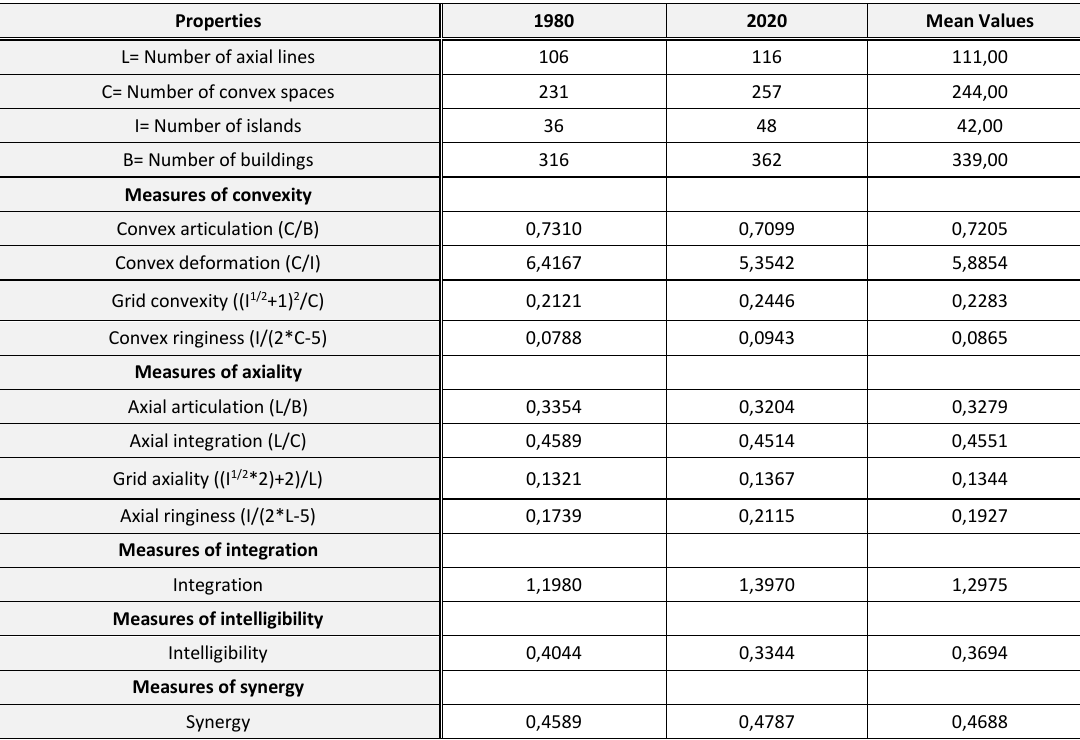
Table 3 Mathematical values of the study area before and after the Galataport Project, complied by (Kubat,